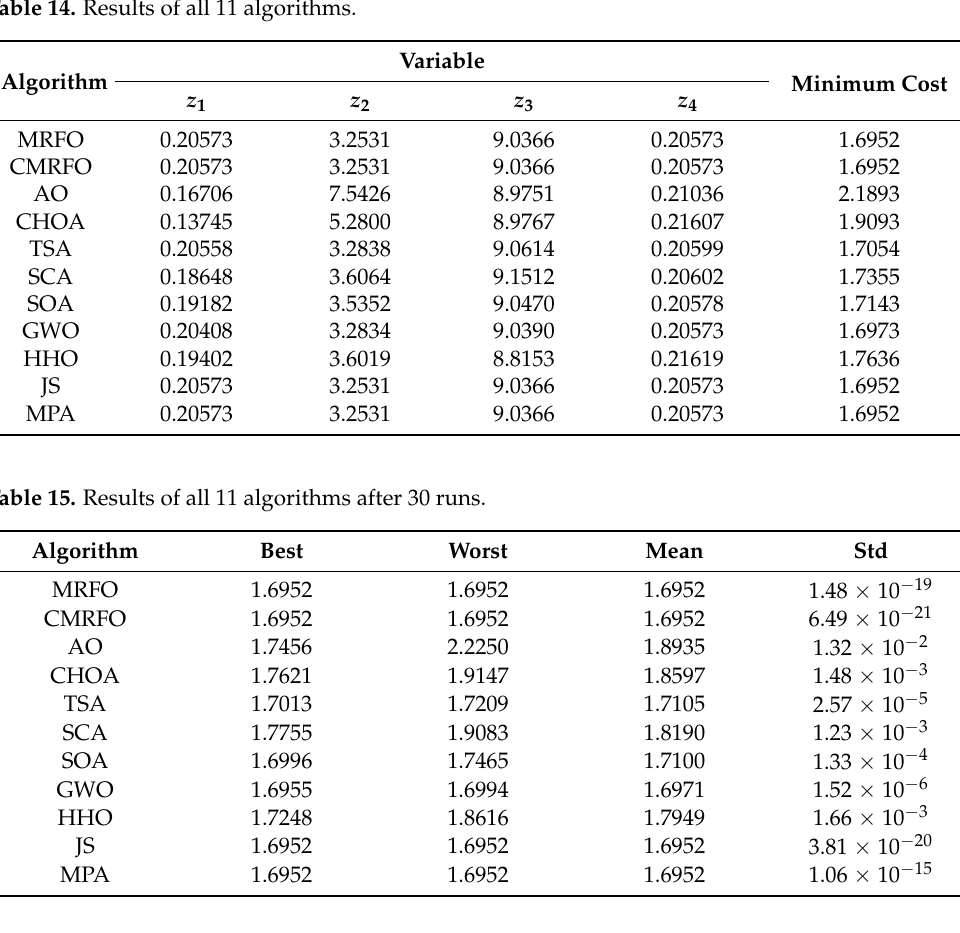
Table 14. Results of all 11 algorithms.